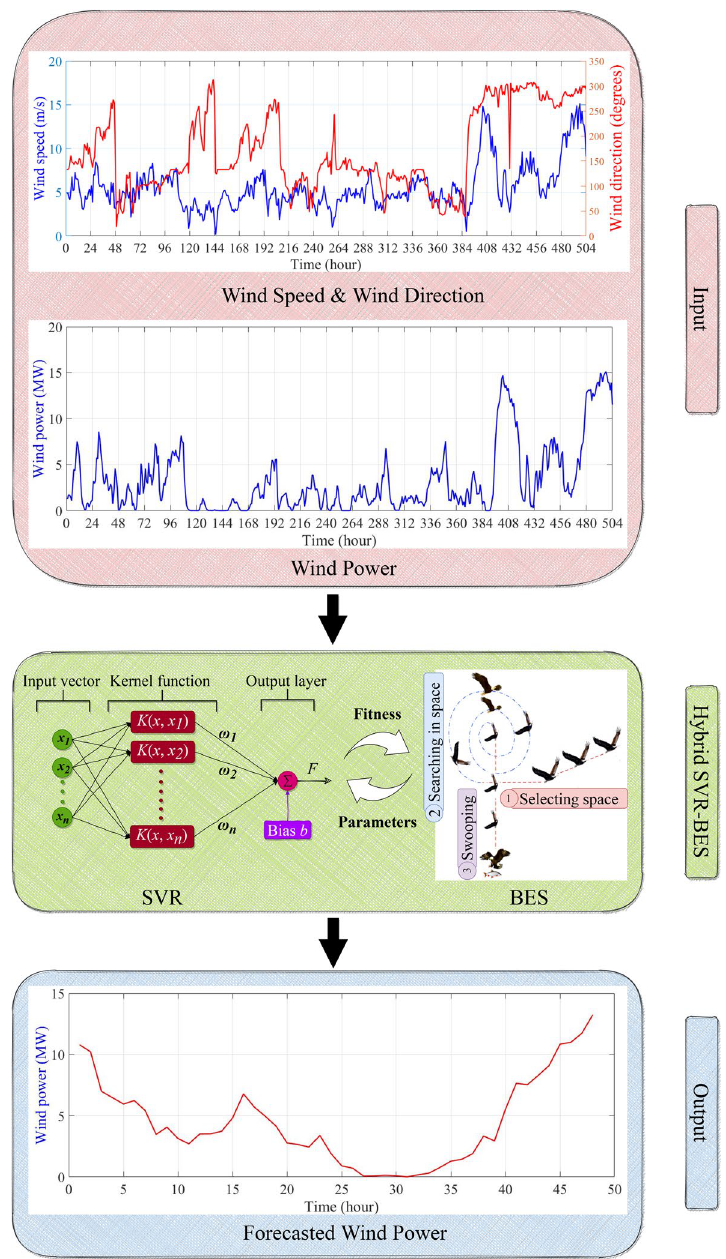
Fig. 3 The framework of the SVR–BES wind power forecasting